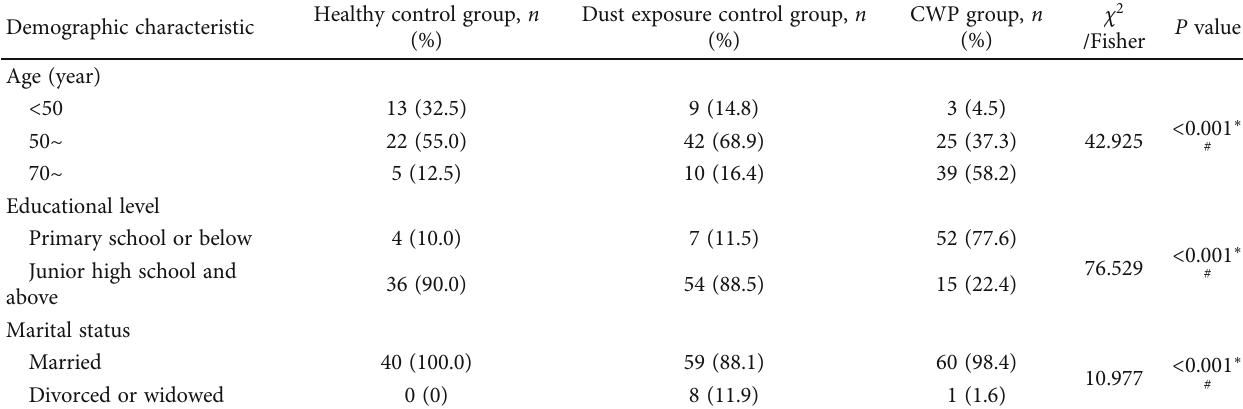
Table 2: Analysis of general demographic characteristics of workers in coal mining enterprises.